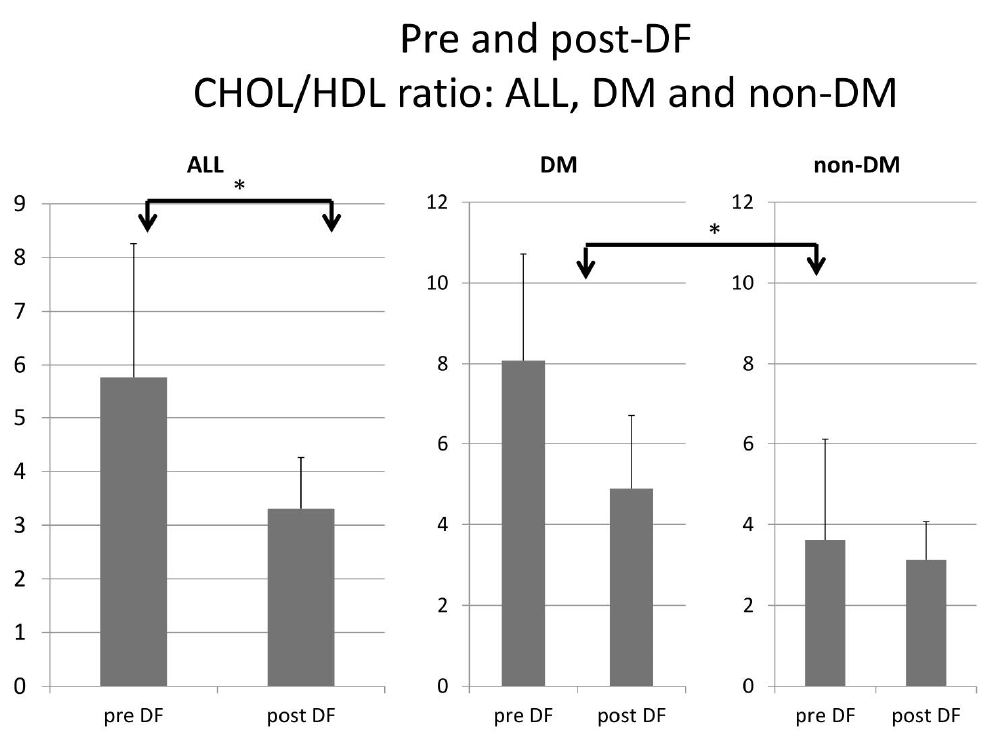
Figure 5. Subgroup comparison of DM and non-DM patients in total cholesterol to HDL ratio. (* for p < 0.05)